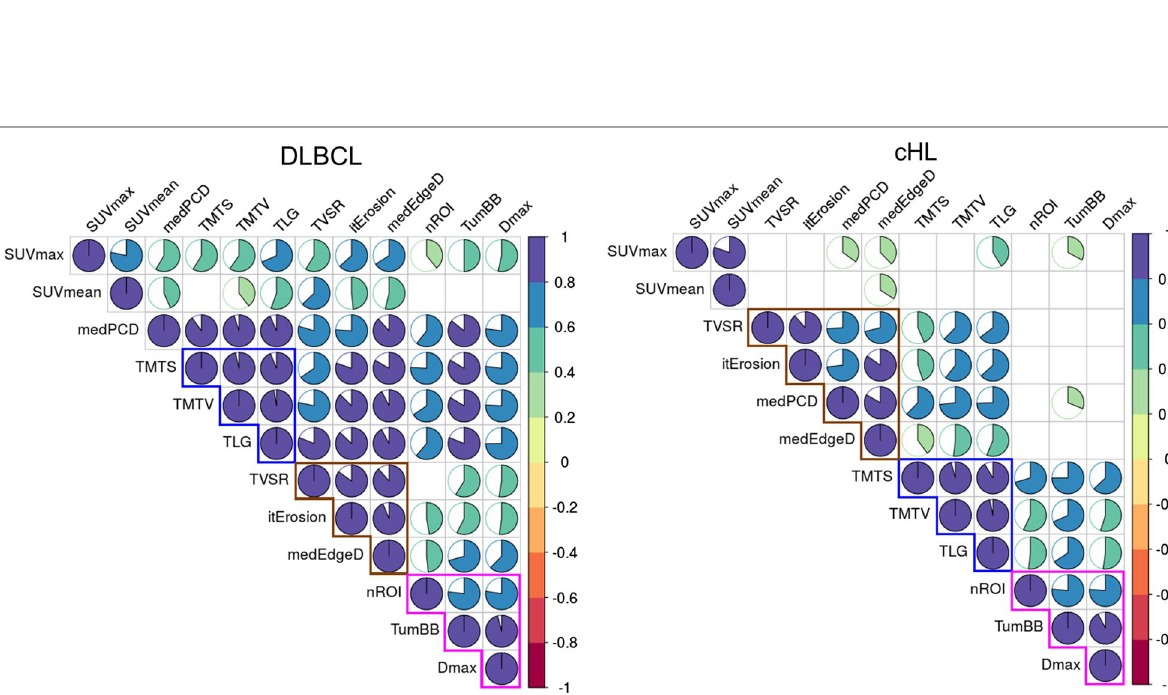
Figure 2 Plot representing clusters of Spearman’s correlations (with p <0.05 controlled by Benjamini–Hochberg correction) between PET parameters for DLBCL and cHL. The blue, brown and rose lines show the three similar clusters found in both DLBCL and